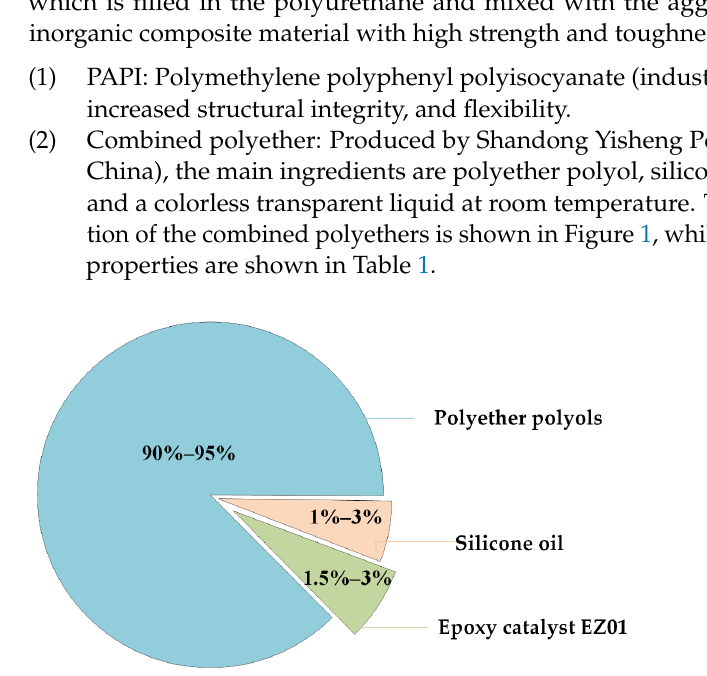
Figure 1. Material composition of combined polyether. Table 1. Physical and chemical properties of combined polyether.